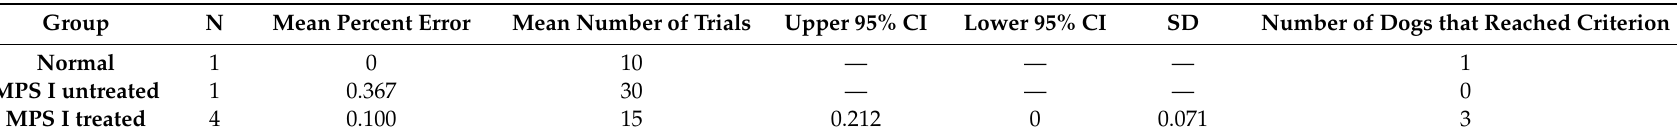
Table 5. DNMP descriptive statistics by group for 30-s delay. This includes the number of dogs tested (N) from each group, mean (real) percent error of each group, mean (real) number of trials performed by each group, 95% confidence interval, standard deviation, and number of dogs from each group that reached the criterion at the 30-s delay.